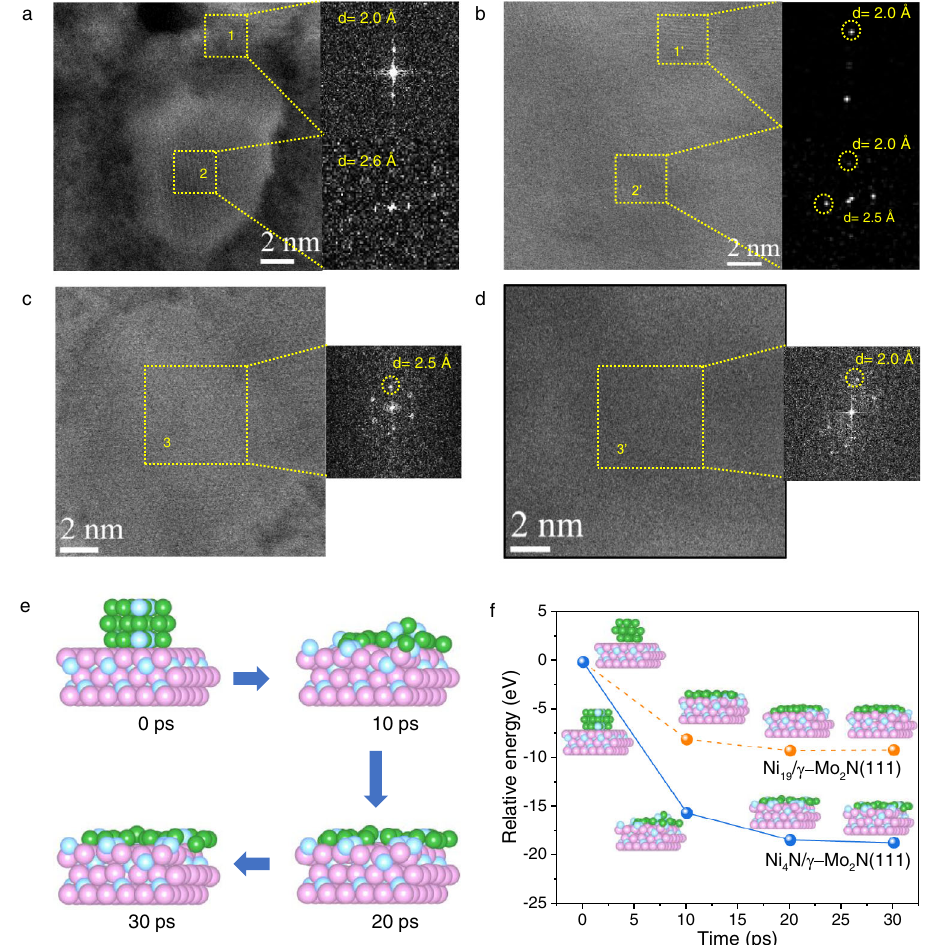
Fig. 6 Comparison of high-resolution environmental SE and BF images. Corresponding FFT patterns of high-resolution ( a , c ) SE and ( b , d ) BF image from the selected area at ( a , b ) 400 °C and ( c , d ) 520 °C. Area 1, 2, and 3 marked in the SE images and the Area 1 ′ , 2 ′ , and 3 ′ marked in the BF images are the at the same position of the catalysts. e The structure evolution of Ni 4 N (Ni 20 N 5 cluster) on γ -Mo 2 N(111) in AIMD calculation in 30 ps; and f the interaction of the free energy change of the redispersion process of Ni 19 / γ -Mo 2 N(111) and Ni 4 N/ γ -Mo 2 N(111). In this fi gure, the green, pink, and light blue atoms are Ni, Mo, and N